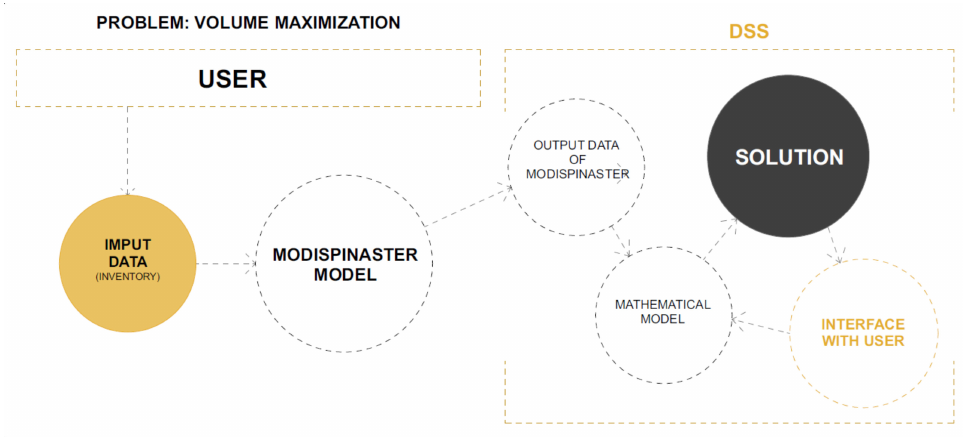
Figure 3. Structure of the DSS